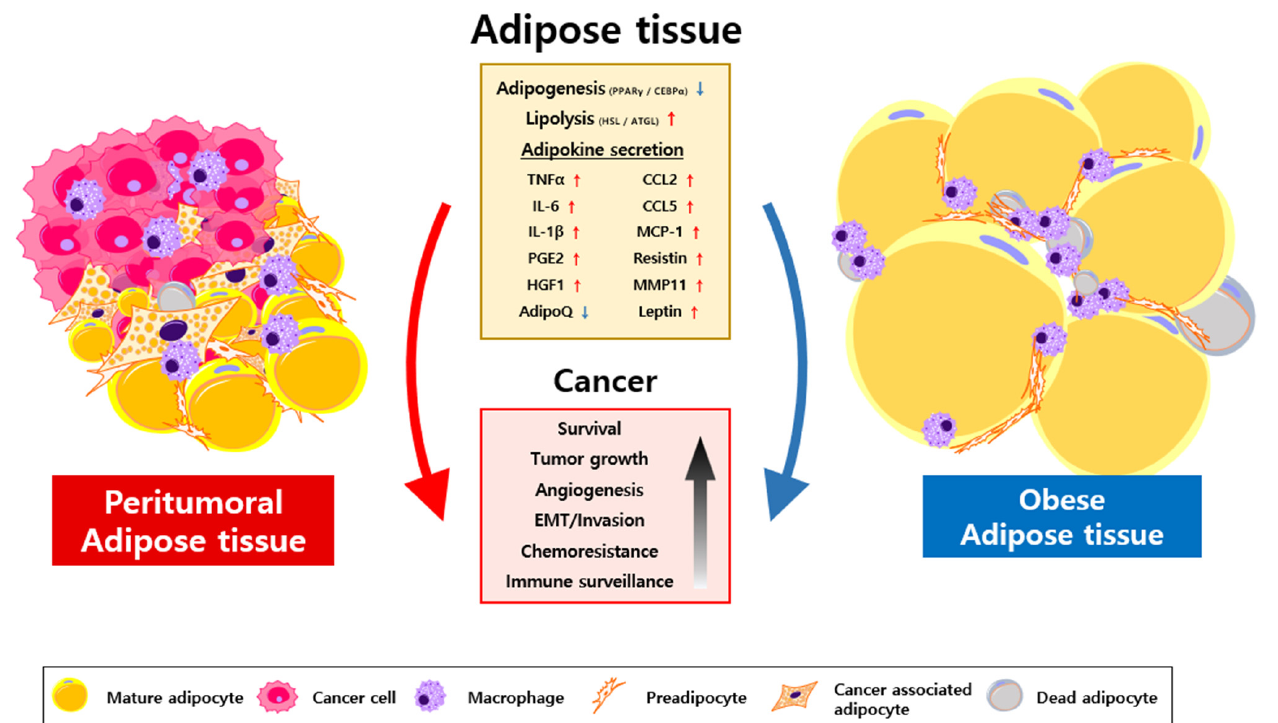
Figure 1. Oncogenic role of peritumoral and obese adipose tissue. Adipocyte characteristics are highly dependent on the environmental condition. At the invasive tumor front, adipocytes are exposed to various signals from cancer cells and are transformed into immature adipocytes. In parallel, under excessive consumption of nutrients, hypertrophic adipose tissue drives adipocyte death and inflammation. Both peritumoral and inflammatory adipose tissues exhibit downregulation of PPAR γ and CEBP α expression, presenting the population of dedifferentiated adipocytes. Activation of lipolysis via key lipases, such as ATGL and HSL, leads to the secretion of various lipid metabolites that support tumor progression. Dedifferentiated adipocytes also provide an altered array of adipokines, which are considered pro-inflammatory and tumorigenic. The induction of adipocyte dedifferentiation and lipolysis contributes to cancer cell survival, growth, epithelial-mesenchymal transition (EMT), chemoresistance, and immune surveillance. Abbreviations: TNF α , tumor necrosis